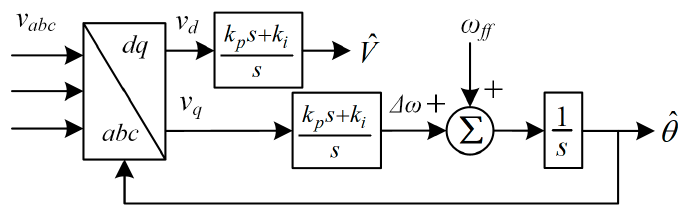
Figure 1. Block schematic of SRF-PLL.